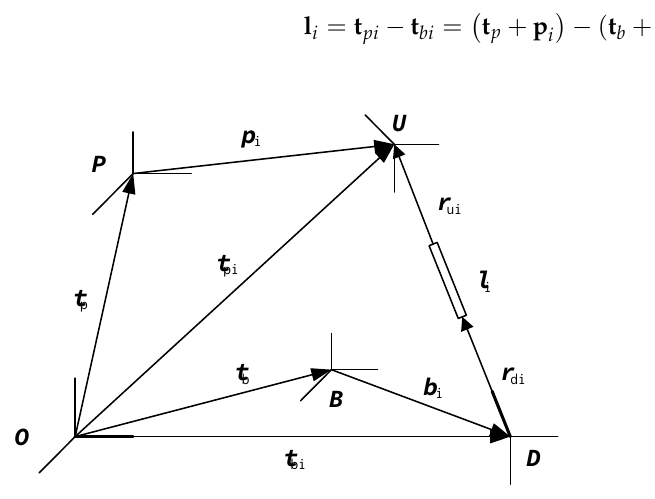
Figure 2. Position vectors of the local frames.